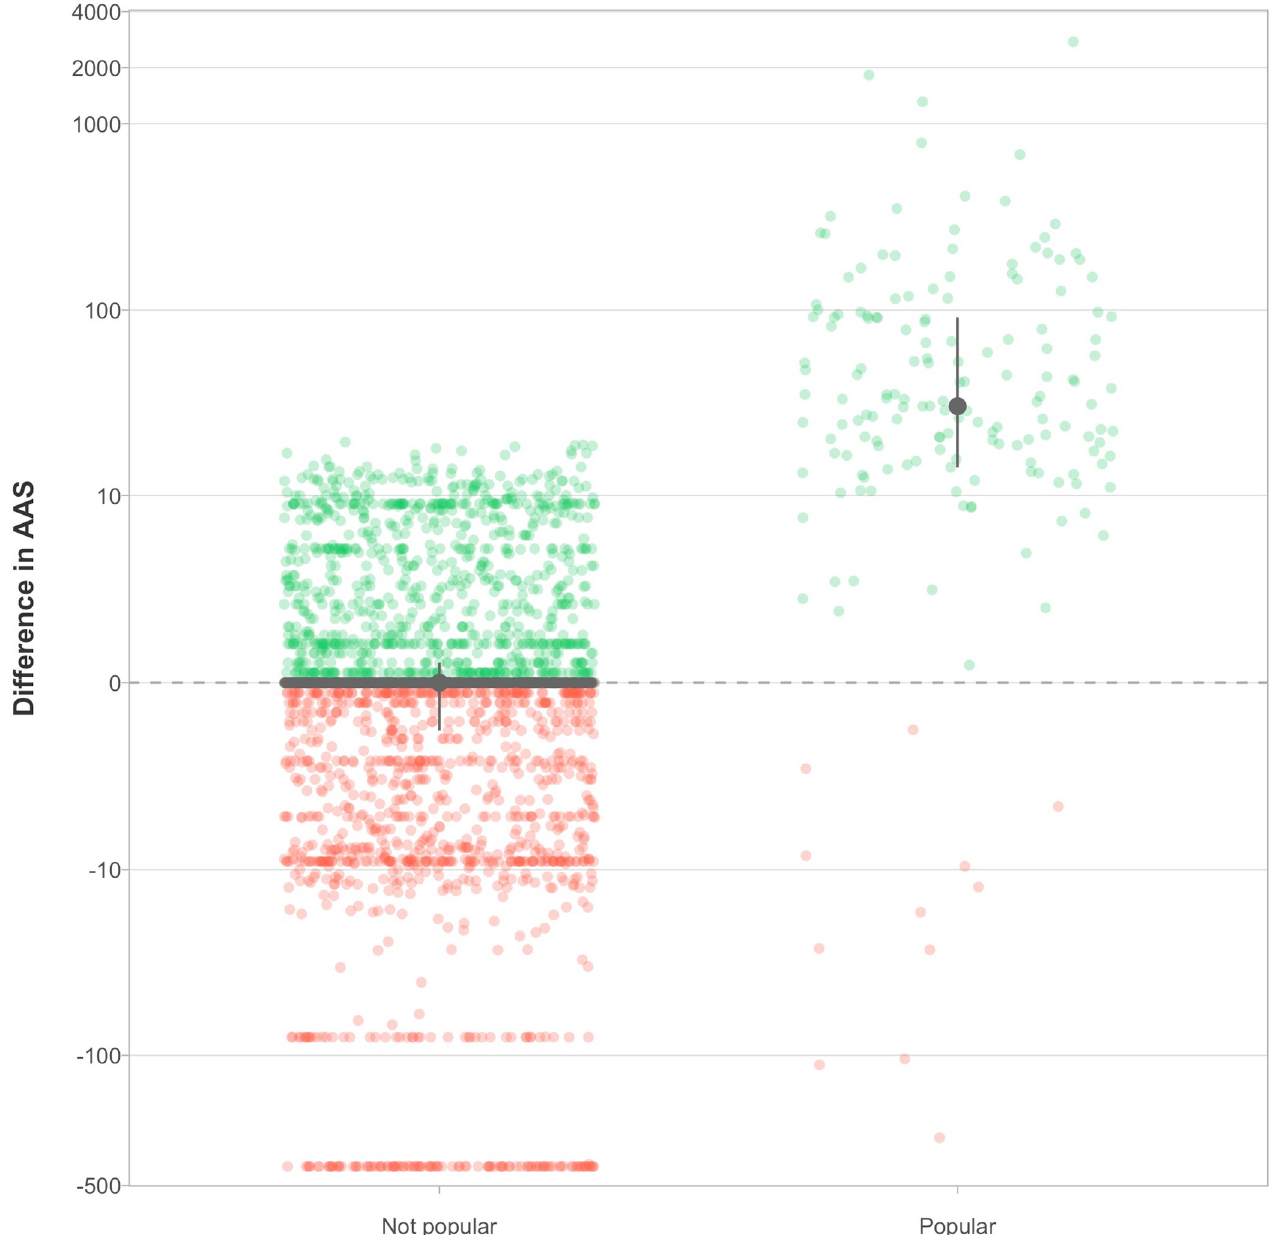
Fig 4. Change in attention by popularity. All points in green represent an original article that received more media and social media attention than its retraction notice and all points in red represent the opposite; points in grey represent no difference between the two. The large point and solid line in grey represent the median and its interquartile range. The difference is rather balanced for 2,923 articles that are not popular—the extreme negative values at -395 came from a single retraction in Tumor Biol, which retracted 103 unique original articles. In 168 popular articles, the difference is skewed to the right such that most popular articles did not have an equally popular